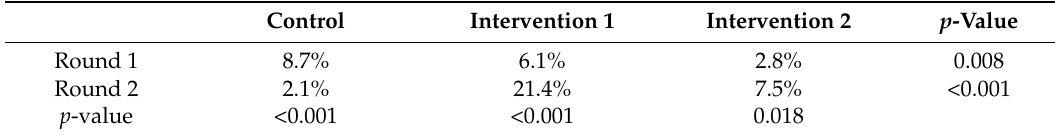
Table 6. DDI-related performance by intervention arm and round: Advise patient of potential DDI.